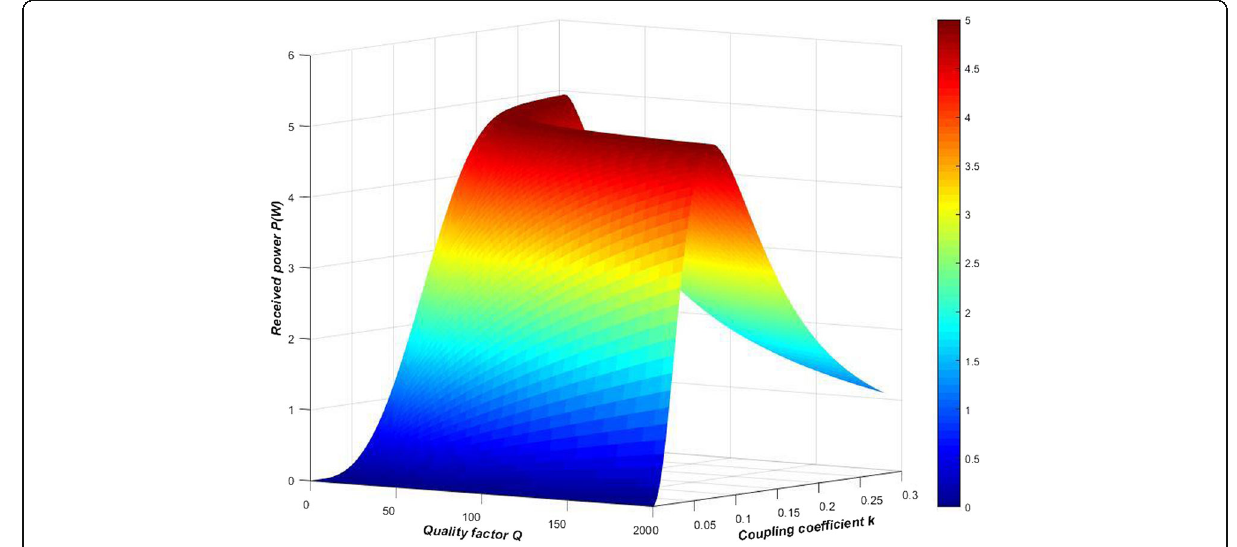
Fig. 5 Influence curve of quality factor and coupling factor on received power